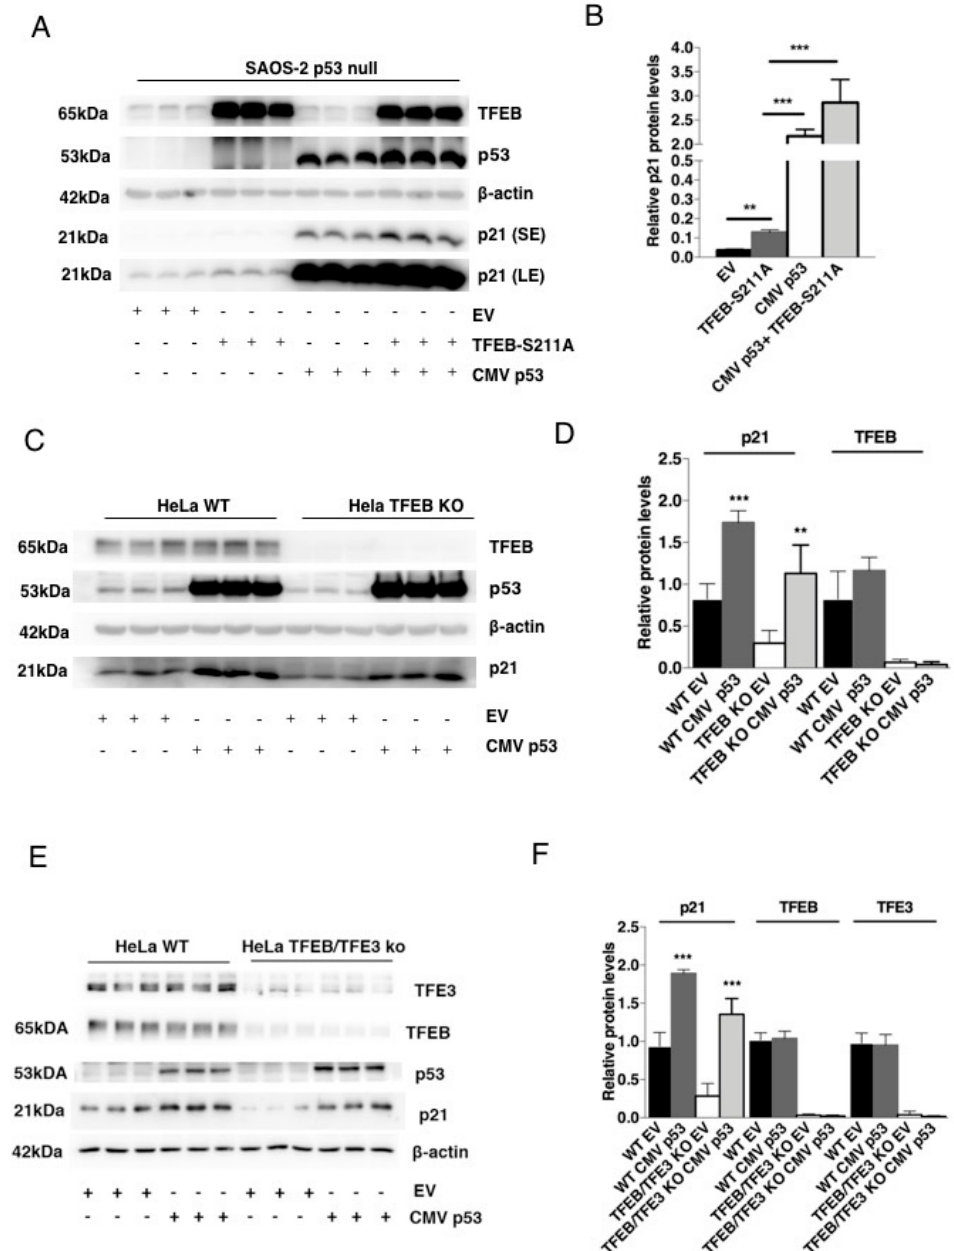
Figure 2. p53 and TFEB regulate p21 expression. ( A , B ) Western blot analysis and quantification of p21 protein levels in SAOS-2 p53 null cells after transfection with an empty vector (3xflagCMV14), a plasmid encoding TFEB S211Ax3flag, a p53-encoding plasmid or the combination of both p53- and TFEB S211A-encoding plasmids. β -actin protein levels were used as loading control. SE (Short exposure); LE (Long exposure). ( C , D ) Western blot analysis and quantification of TFEB and p21 protein levels in HeLa WT compared with TFEB KO cells after transfection with either an empty vector (3xflagCMV14) or a plasmid encoding p53. β -actin protein levels were used as loading control. ( E , F ) Western blot analysis and quantification of TFEB, TFE3, and p21 protein levels in HeLa WT compared with TFEB / TFE3 KO cells after transfection with either an empty vector (3xflagCMV14) or a plasmid encoding p53. β -actin protein levels were used as loading control. Data are represented as mean ± SEM of three independent experiments (protein) or two independent experiments (mRNA). ** p < 0.01, *** p < 0.001 (two-tailed Student’s